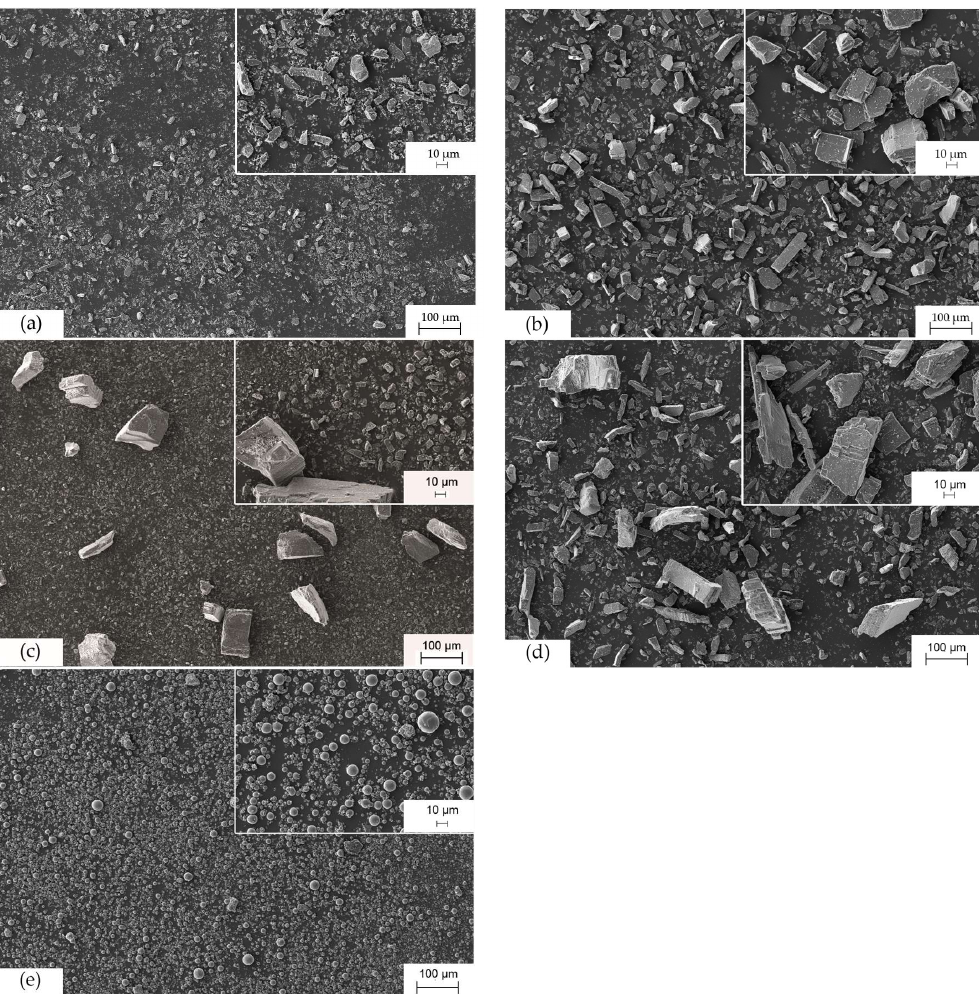
Figure 4. Microstructure of fillers photographed by SEM. ( a ) Silatherm 1360-400; ( b ) Silatherm 1360-010; ( c ) Silatherm 1360-506; ( d ) Silatherm 1360-007; ( e ) Silatherm Plus 1432-400.